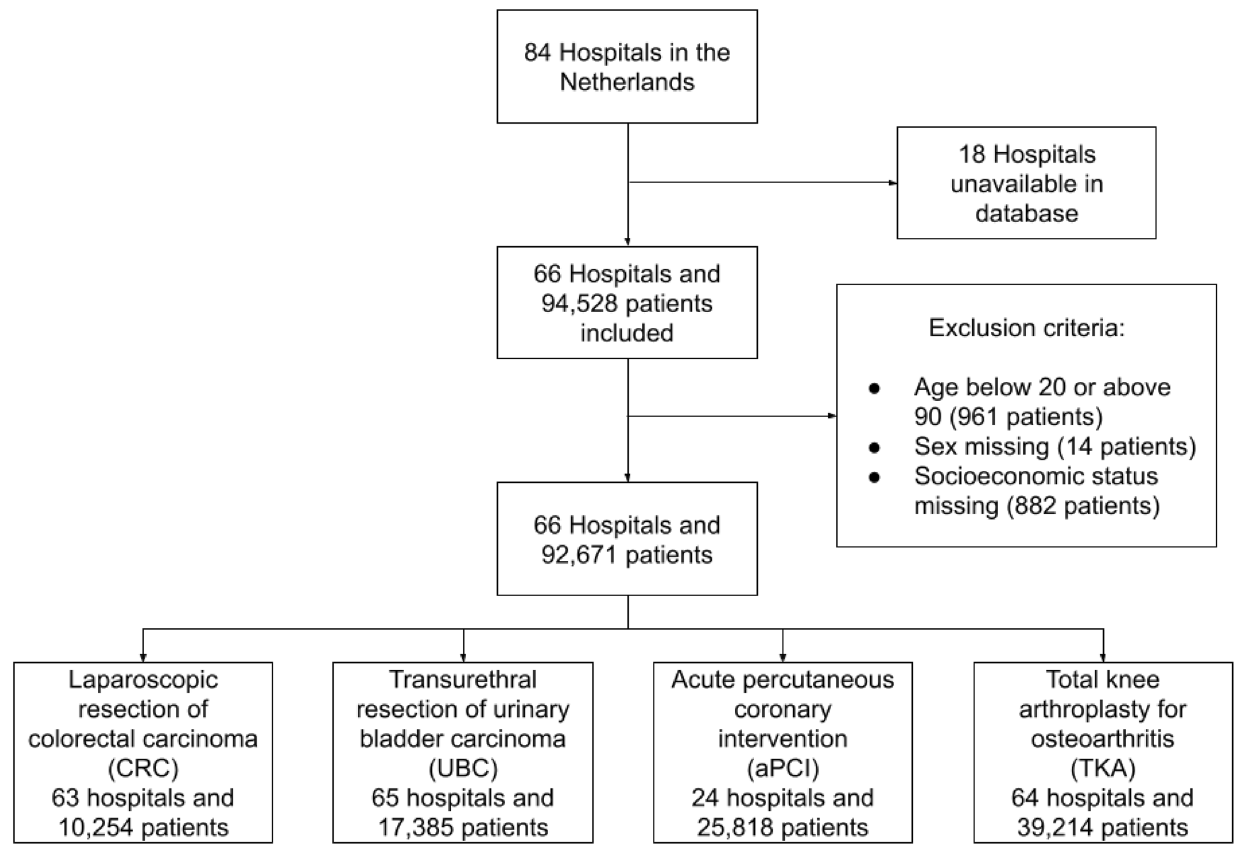
Figure 1. Flowchart describing study population and